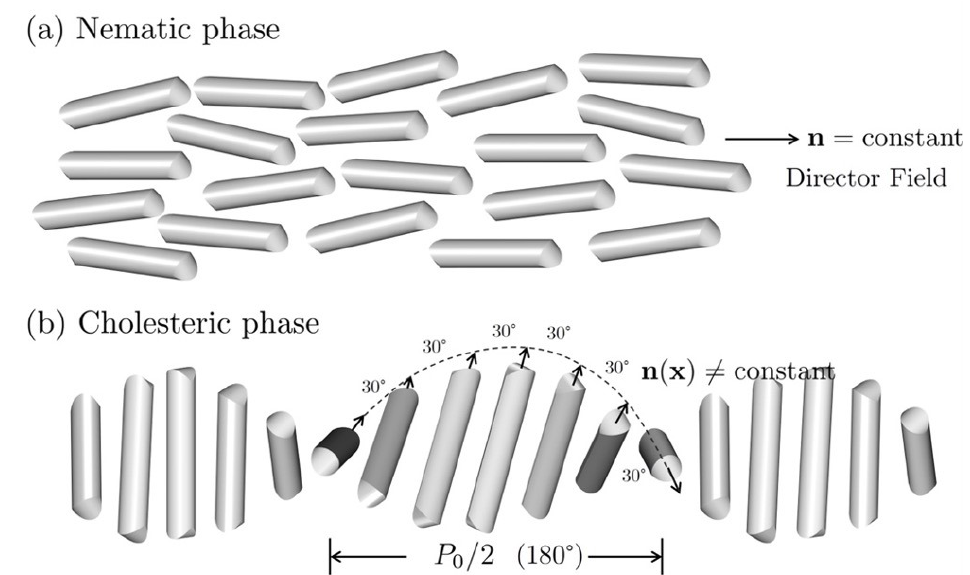
Figure 1. Nematic and cholesteric liquid crystal phases show different symmetry. ( a ) The nematic liquid crystal phase with an anisotropy axis n known as the director. ( b ) The chiral cholesteric liquid crystal phase with a spatial periodicity P 0